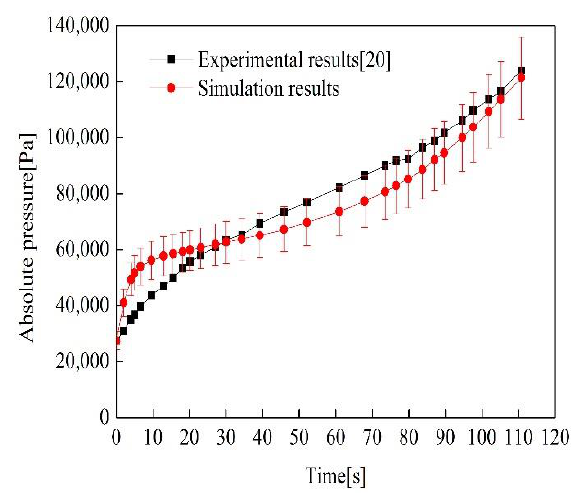
Figure 8. Validation of the phase change model in the filling process.